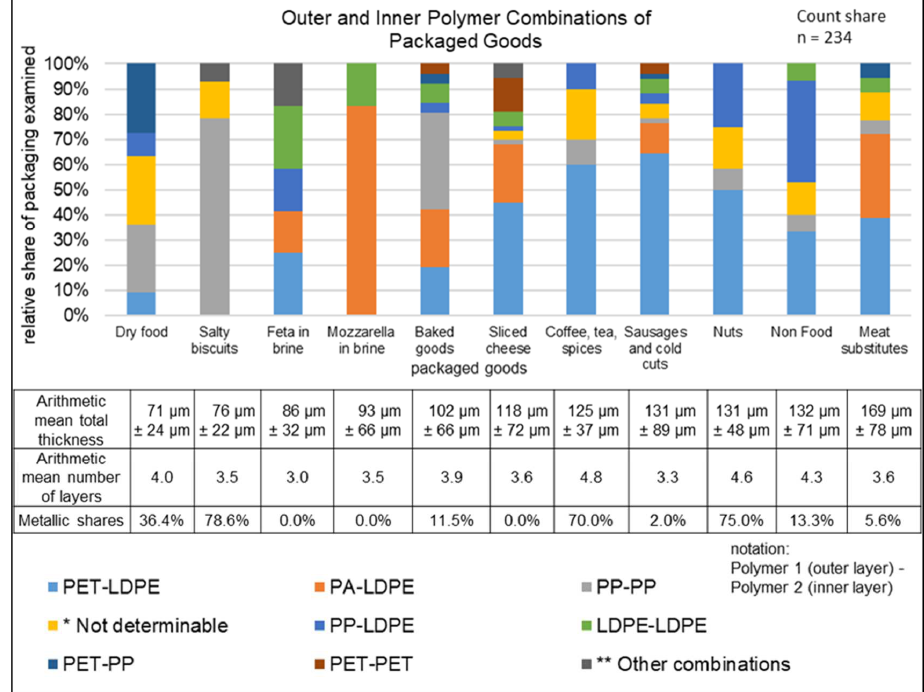
Figure 3. Analysis of the packaging with respect to packaging type and storage conditions. * PA-n.d.; PET-n.d.; n.d.-n.d.; n.d.-PP; n.d.-LDPE; ** PP-PET; LDPE-PET; PET-HDPE; PE-LD-PA; PA-PP; PA-PA.